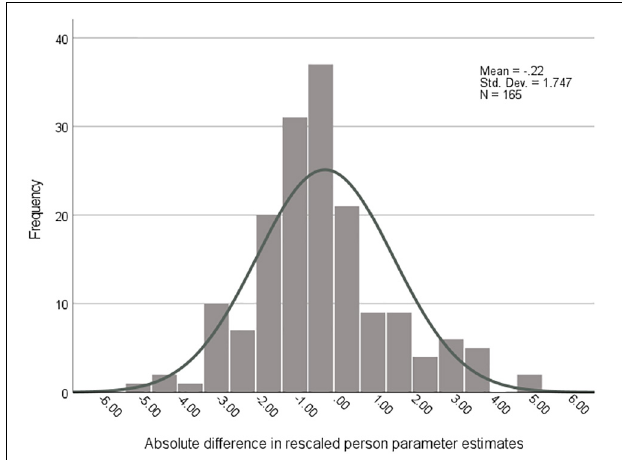
FIGURE 1 | Distribution of differences in Critical Thinking scores (rescaled person parameter estimates) from baseline to follow-up. Differences are shown as follow-up minus baseline so that positive values show an increase and negative values show a decline in critical thinking over time. Distances between any two scores are